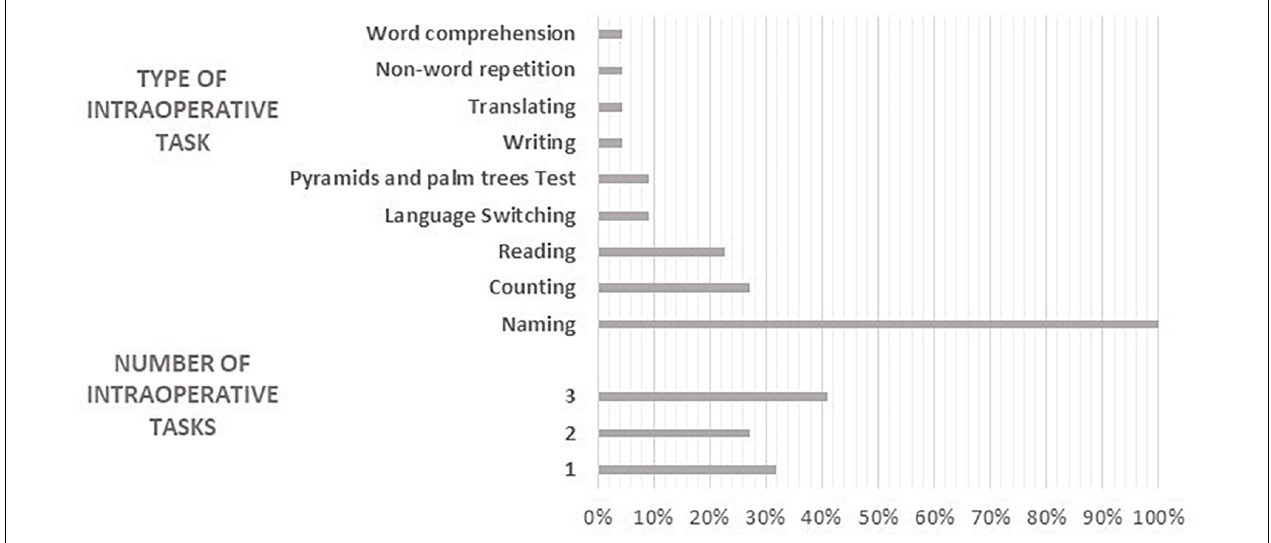
FIGURE 5 | Number and type of intraoperative